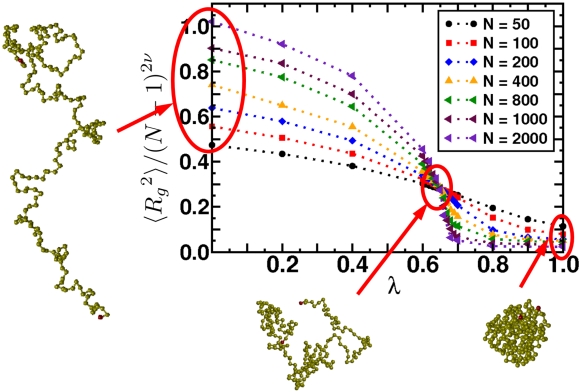
Coil-to-globule transition from good to bad solvent behavior of a polymer chain. Plot of 〈Rg2〉 / (N – 1)2ν vs. interaction parameter λ for linear chains. The points represent the simulated data and the dotted lines are guides to the eye. ν = νθ = 0.5. Also displayed are simulation snapshots of linear chains for the three cases of a good, θ-, and a bad solvent.